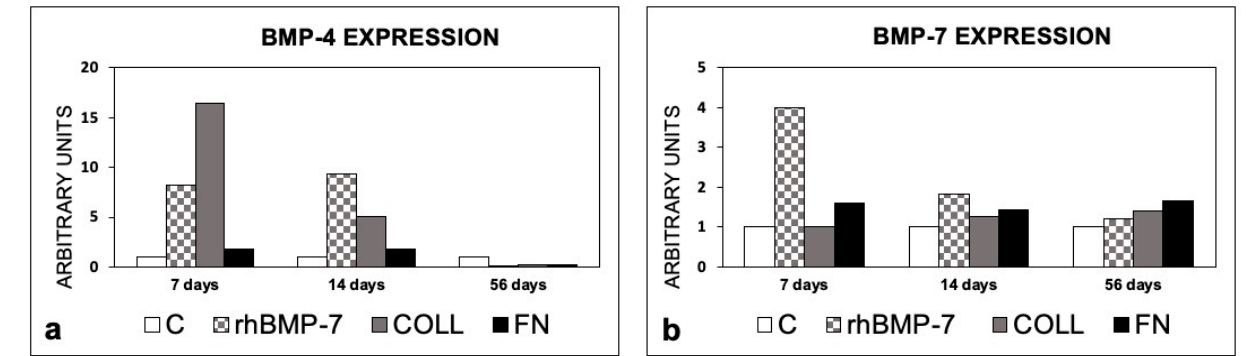
Figure 8. Expression of BMP-4 and BMP-7 in peri-implant bone tissues from sites treated with rhBMP-7, Type 1 Collagen,